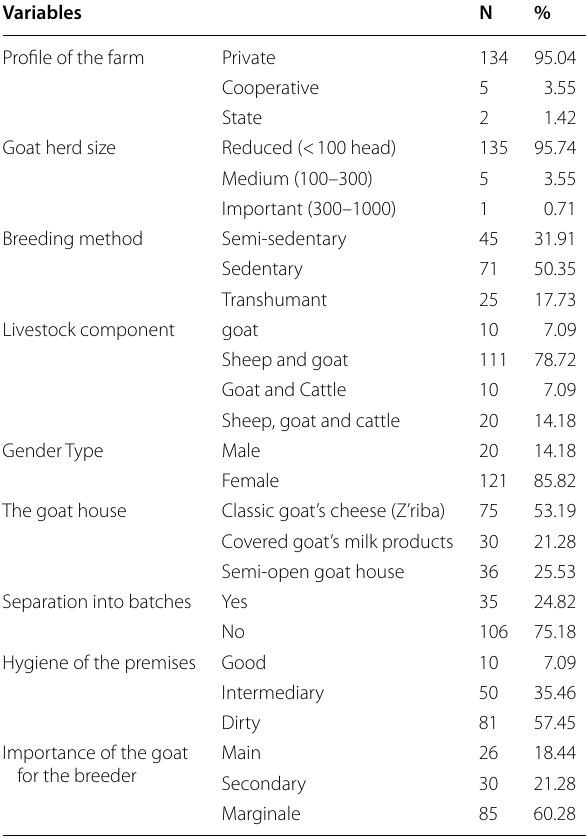
Table 2 Characteristics of goat rearing in the different study